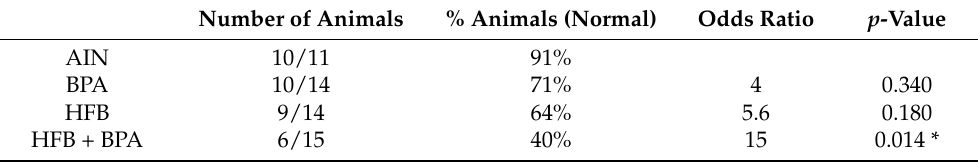
Table 3. Presence of spermatozoa in ≥ 14% of STs (T + E2) in testes of F3-generation SD rats. Number of Animals